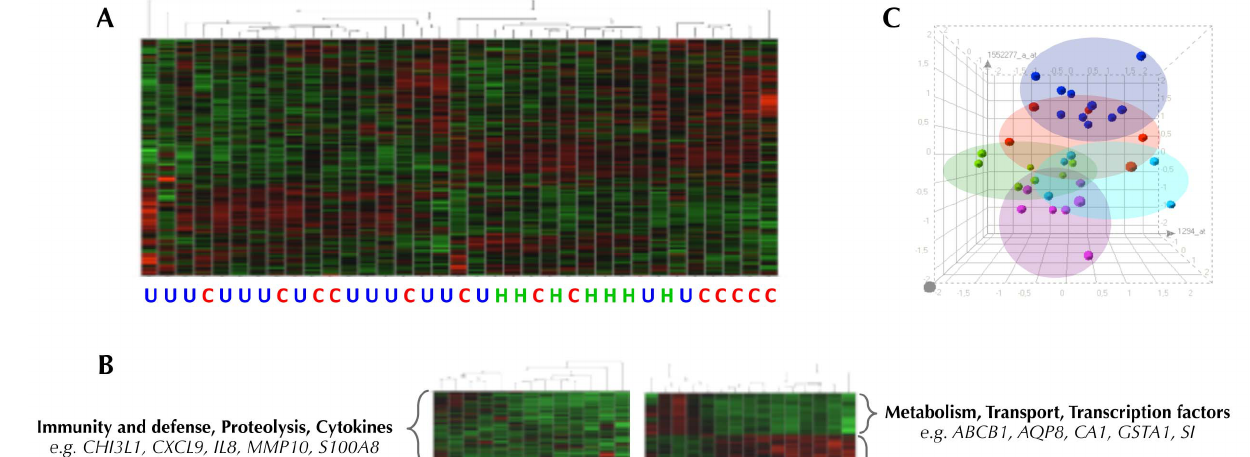
vs. UC2. Figure 5 summarizes the best sets of genes found to correctly classify patients between these groups. The predictor classifiers of IBD forms vs. healthy samples showed the highest accuracy ( . 90%) but it dropped to 79% (CD vs. UC), 85% (CD1 vs. UC1) and 68% (CD2 vs. UC2). This result underlines the high similarity of both conditions at the gene expression level. The best predictor of CD vs . UC consisted of 5 genes with a prediction error of 21% (Figure 5D). A set of 10 genes was found to be the best predictor between the ‘‘High Inflammation’’ subgroups (CD2 and UC2) although the prediction error increased to 33% (Figure 5F).